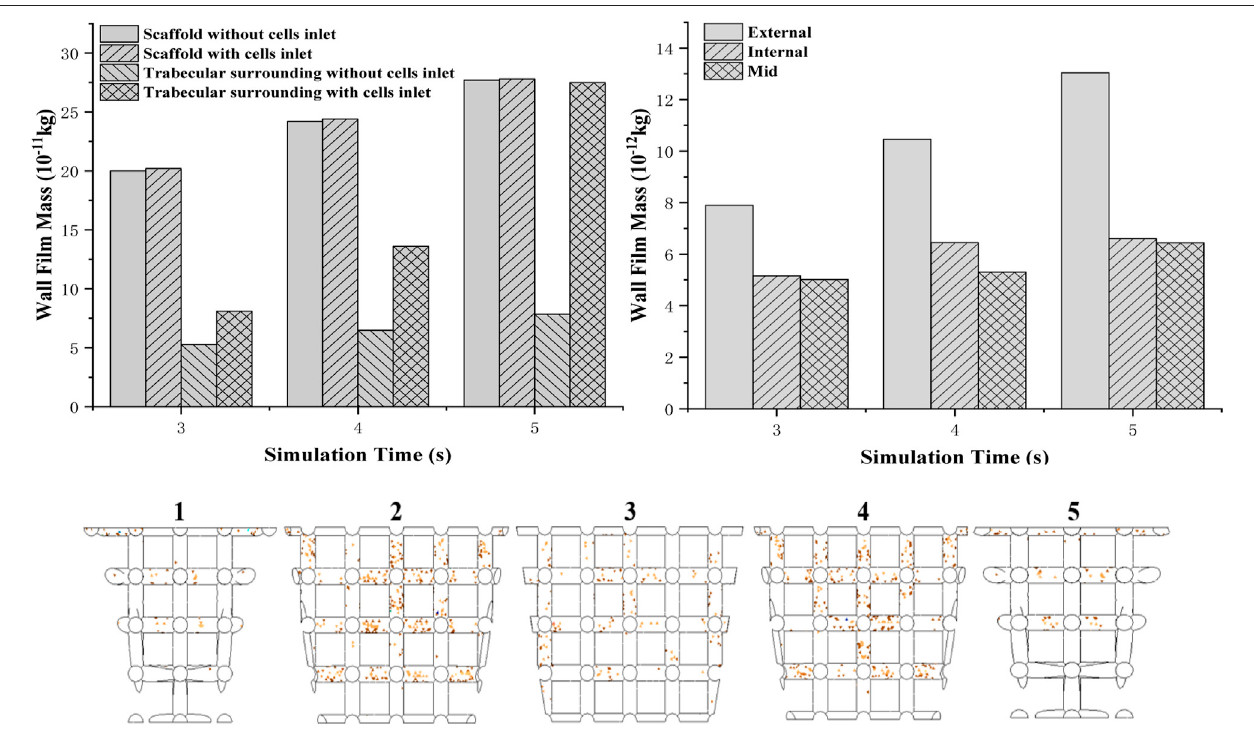
FIGURE9 | Twodifferentboundary conditions ofcells attached toamassofscaffoldand boundary wall (topleft) ; cell(density) distribution in thescaffold from the edge to the middle (top right) ; simulation of cell attachment at 3 s — boundary conditions: no cells injection (bottom) .